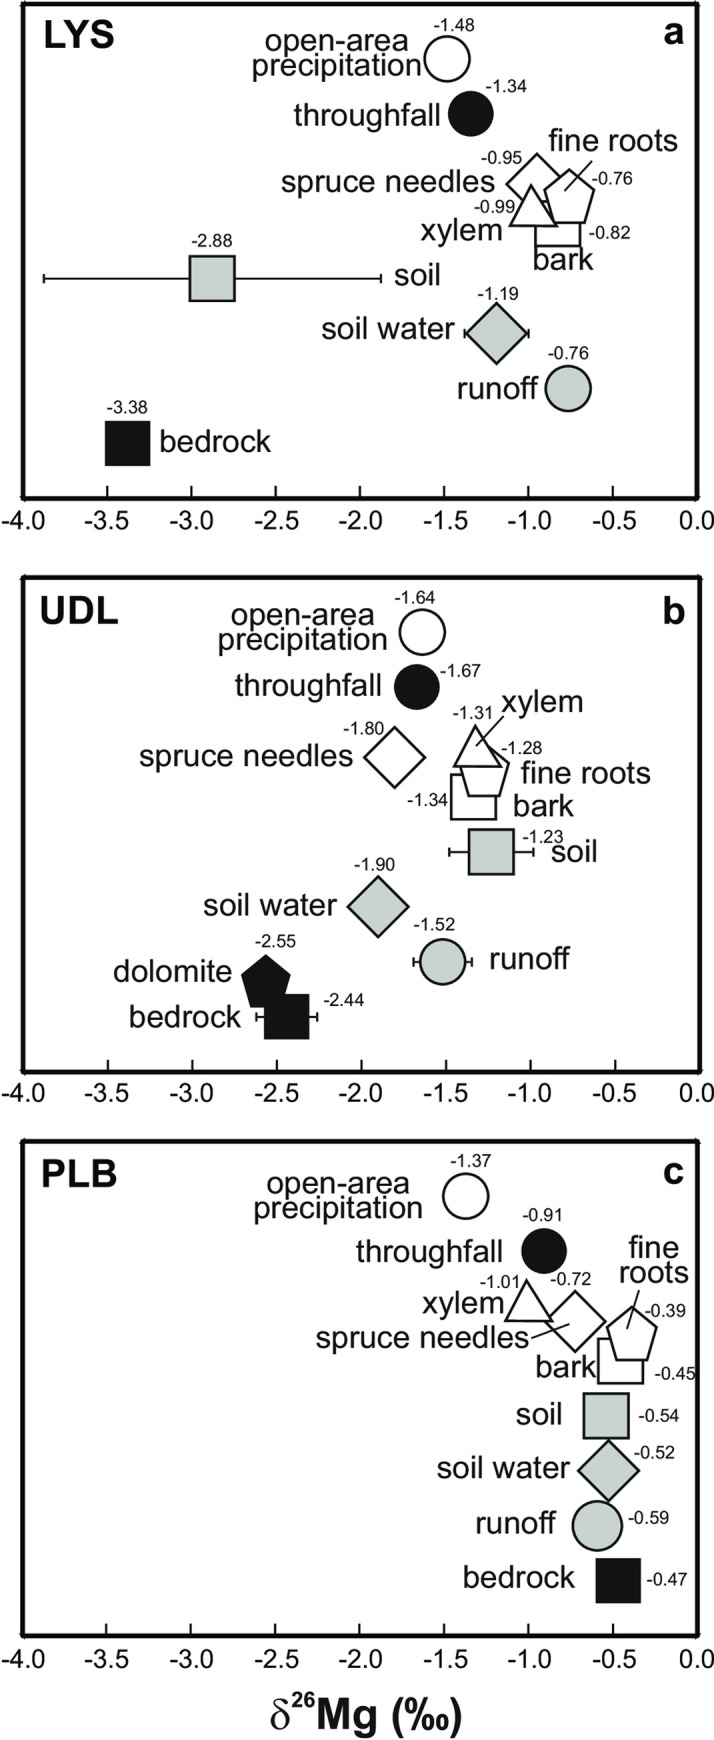
The measured Mg isotope systematics at LYS (a), UDL (b) and PLB (c). Arithmetic means are given for δ26Mg values from bulk soil profiles. For individual Mg isotope measurements see
S2 Table.